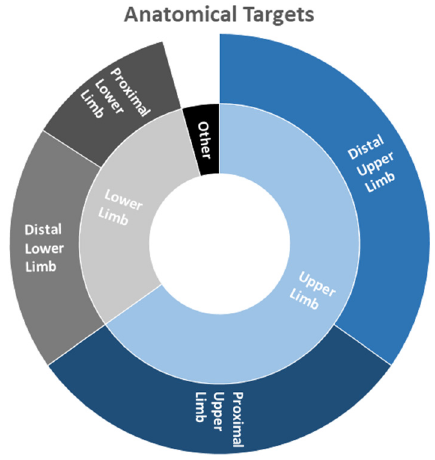
Figure 7. Hierarchical representation of anatomical targets considered in the analyzed documents.